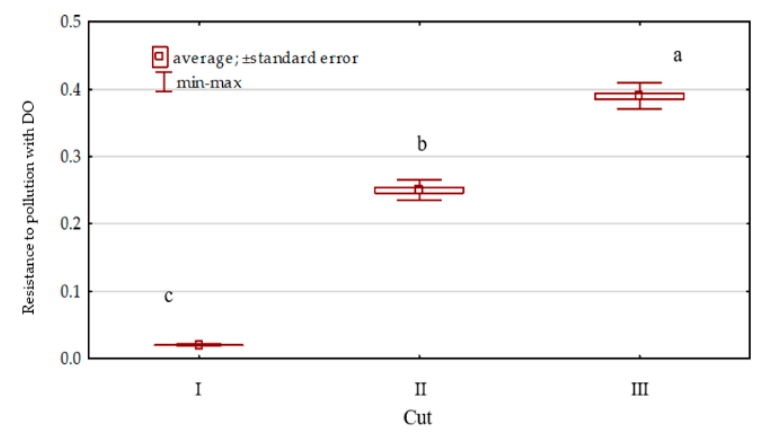
Figure 10. Dactylis glomerata resistance to soil pollution with diesel oil (DO) soil contamination.